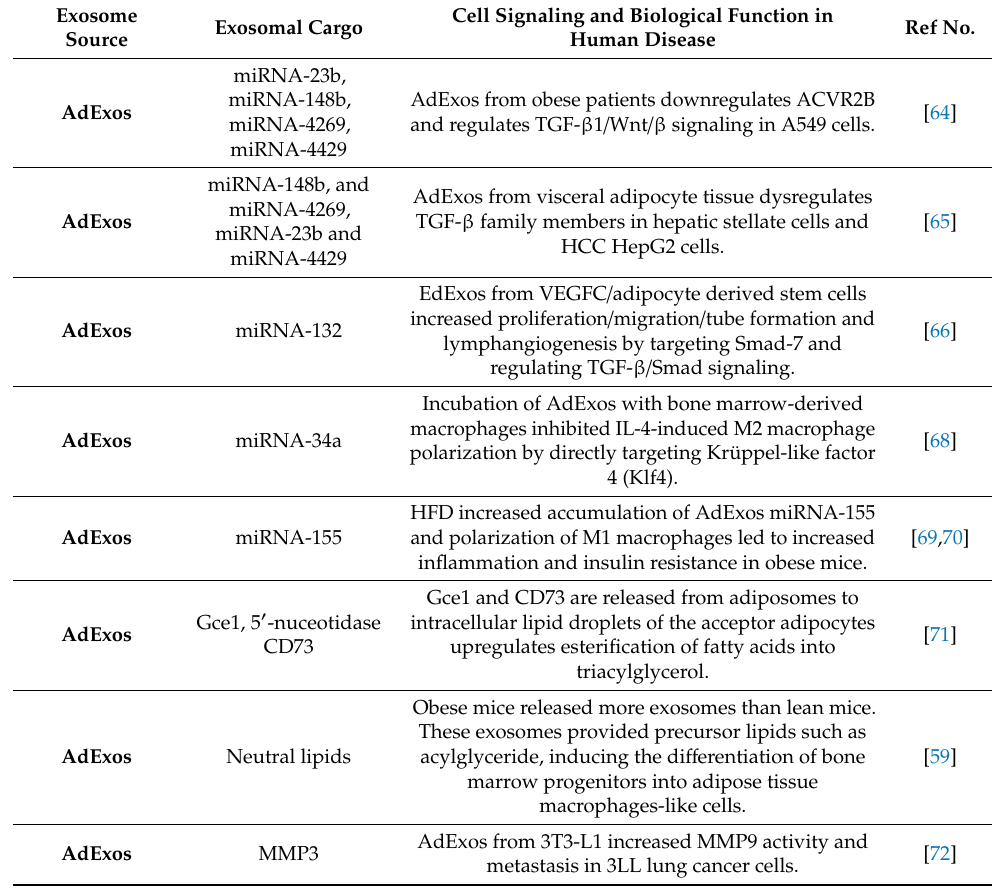
Table 1. Exosome source, cargo and function in